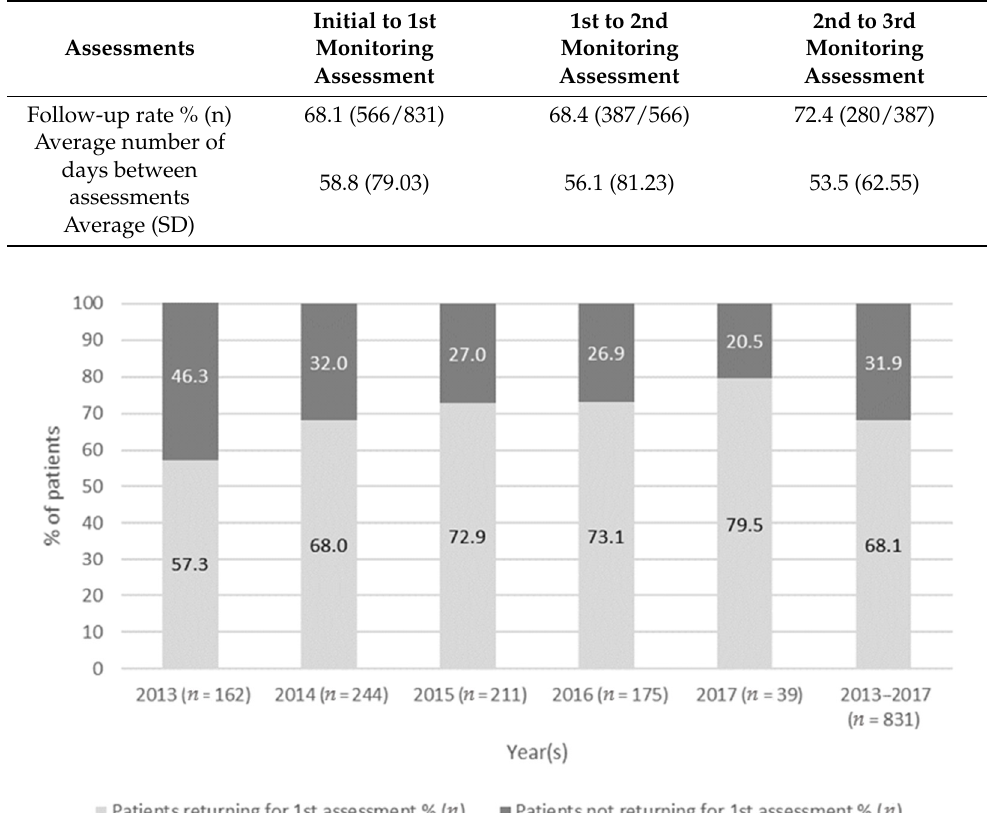
Table 3. Follow-up rates and days elapsing between the first three monitoring assessments.